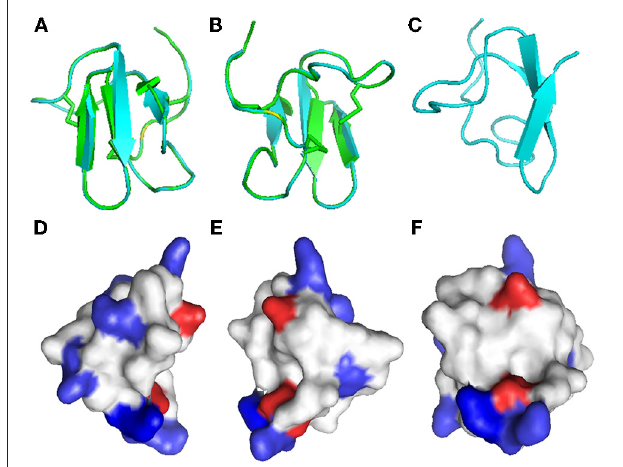
FIGURE 6 | Homology modeling of Juruin. Comparison of Juruin and U1-theraphotoxin-Ba1a(PDB ID: 2KGH), from Brachypelma ruhnaui , structures. (A,B) Juruin (blue) and U1-theraphotoxin-Ba1a(green) ribbon structures were superimposed over the backbone atoms. (C) Ribbon structure of Juruin in a different view related by ∼ 90 ◦ rotation. (D,E) Molecular surface of Juruin highlighted to show electrostatic potential, surfaces with positive, negative, and neutral electrostatic potentials are drawn in blue, red, and white, respectively. (F) The Lys 22 -Lys 23 segment shows maximum positive charge localization represented by the intense blue color. Model pairs show the sides of the protein rotated by ∼ 180 ◦